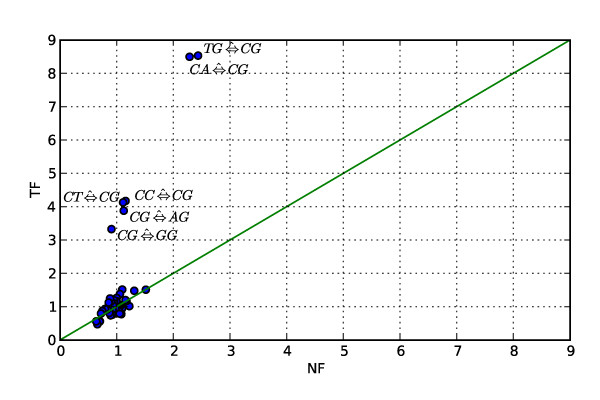
Relationship between dinucleotide MLEs obtained under TF and NF from primate data. Plotted are the mean MLEs for rate parameters obtained under NFnuGTR+Parameter (x-axis) and TFnuGTR+Parameter (y-axis) forms. Means and their standard errors were estimated using the jackknife procedure. Standard errors are not shown as they were smaller than the plotted marker sizes. Coordinates corresponding to the CpG related rate parameters are labelled.